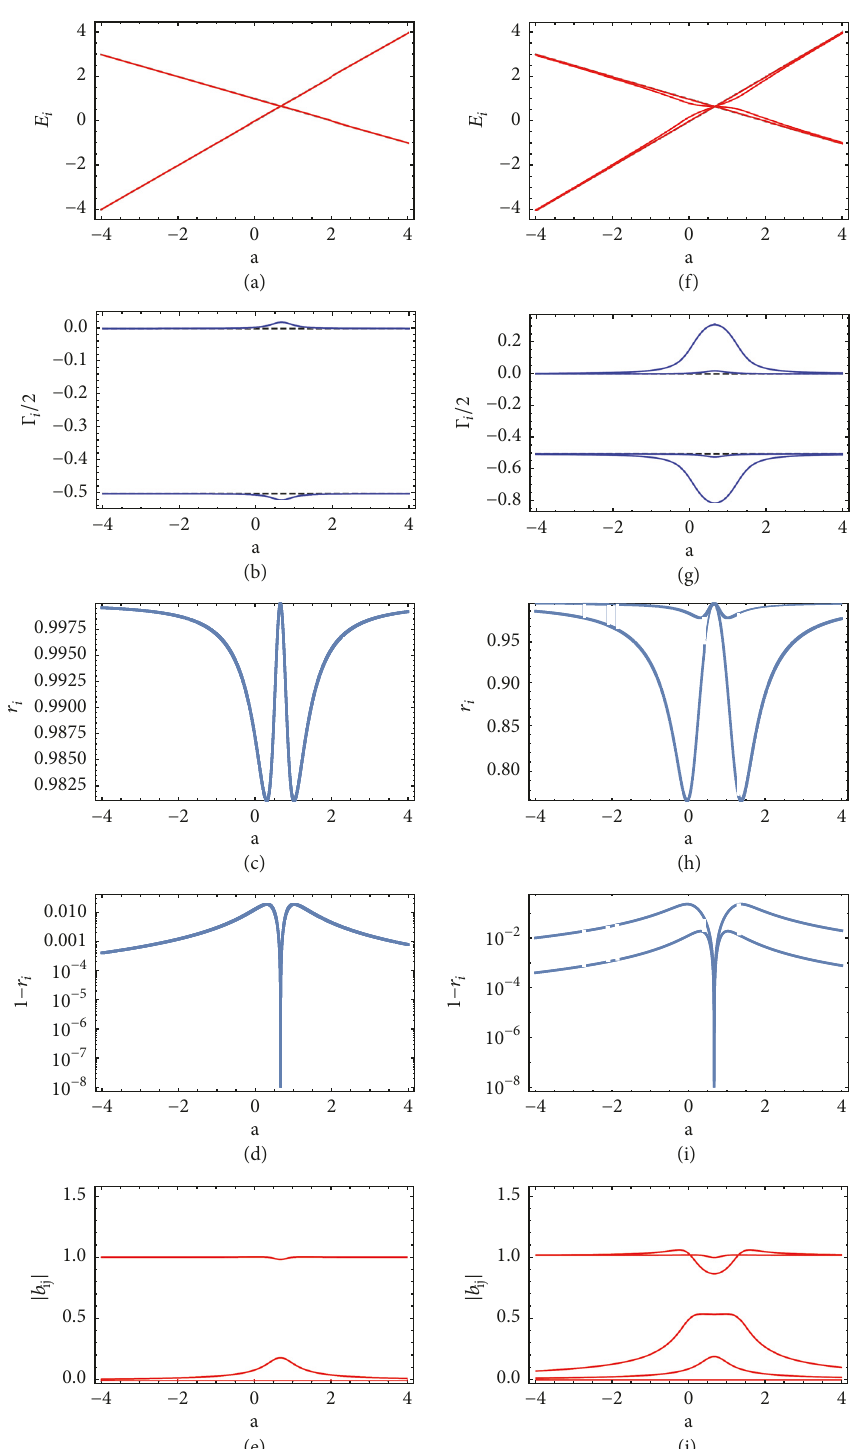
Figure 1: Eigenvalues E (1,2) 𝑖 ≡ 𝐸 (1,2) 𝑖 +(𝑖/2)Γ (1,2) 𝑖 and eigenfunctions Φ (1,2) 𝑖 of the Hamiltonian H (2,2) as a function of 𝑎 . 𝜔 (1) = 𝜔 (2) = 0.1𝑖 (left), 𝜔 (1) = 0.5𝑖 ; 𝜔 (2) = 0.1𝑖 (right). Parameters: 𝑒 the critical parameter value 𝑎 = 𝑎 cr = 0.6494 , the phase rigidity 𝑟 𝑖 approaches value 1